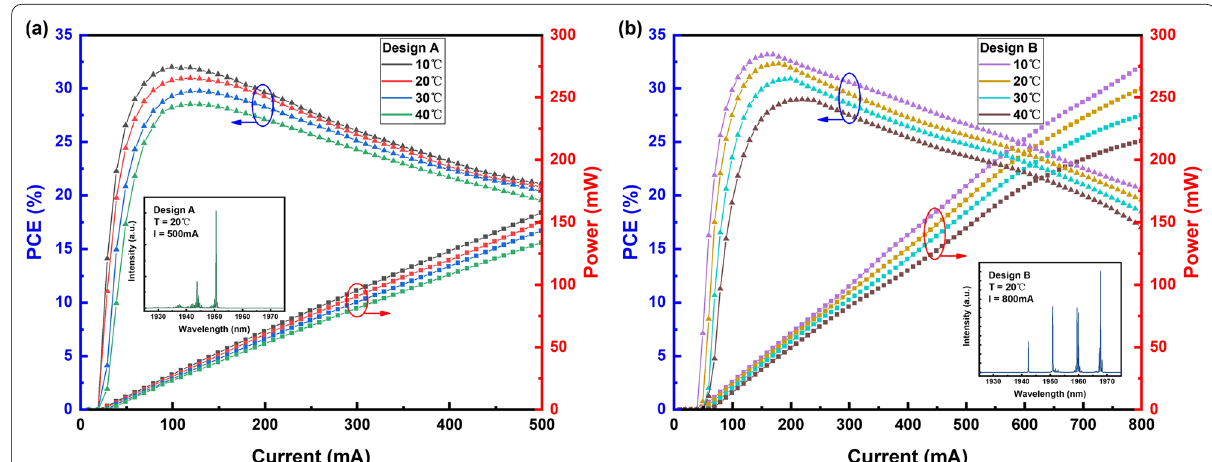
Fig. 4 P-I-PCE characteristics of the RW laser designs under CW operation at different heat sink temperatures: a Design A and b Design B. The insets show the emission spectrums at the maximum operating currents of Designs A and B,